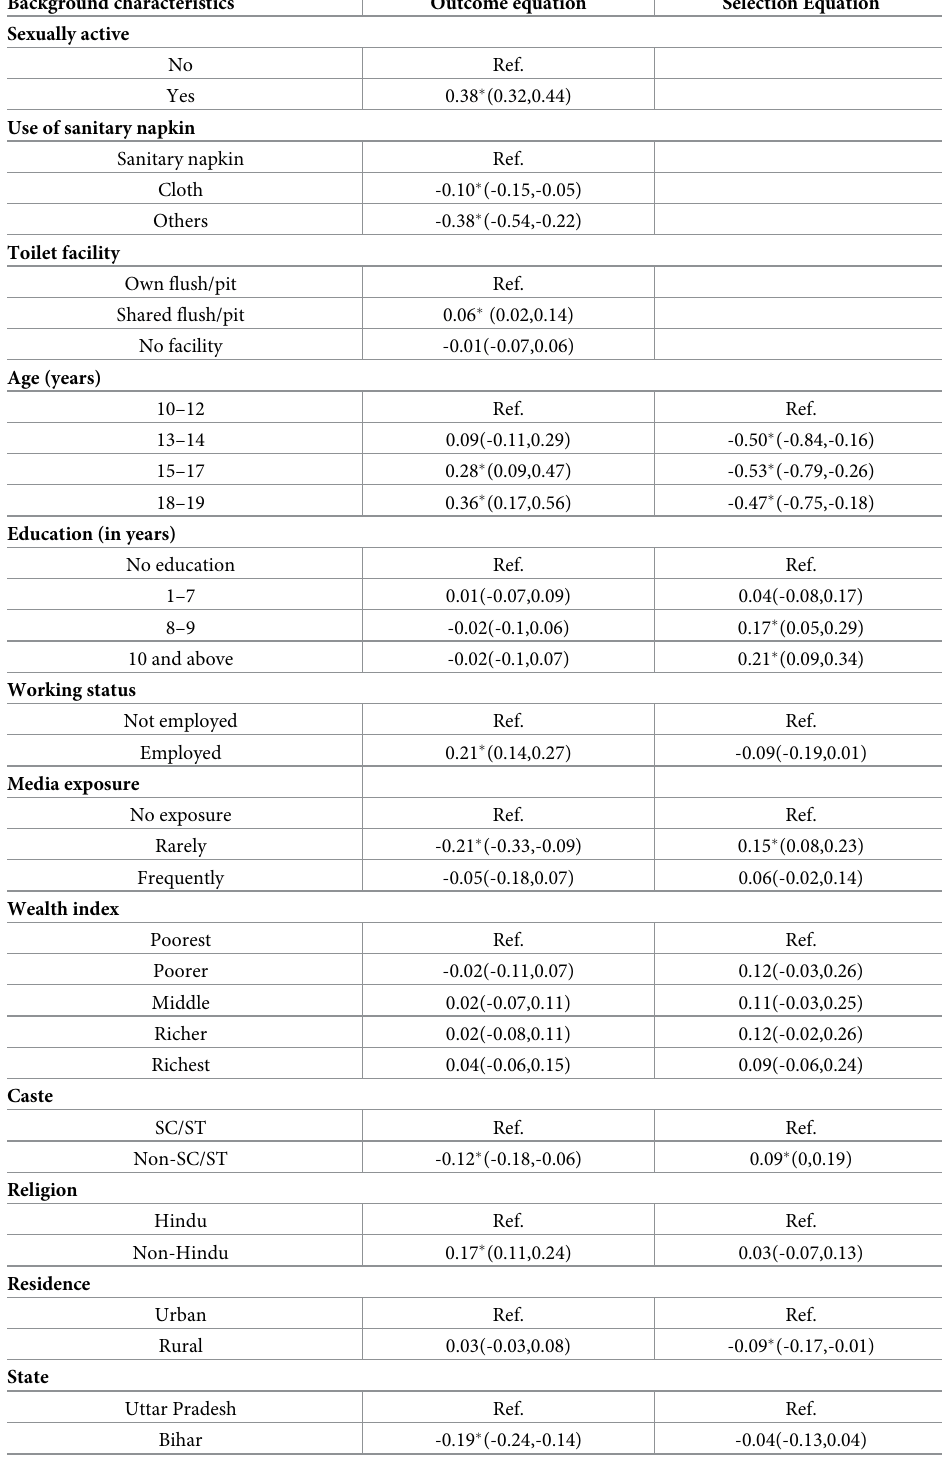
Table 3. Estimates from heck probit model for determinants of gynaecological morbidity and its treatment-seek- ing behavior among adolescents aged 10–19